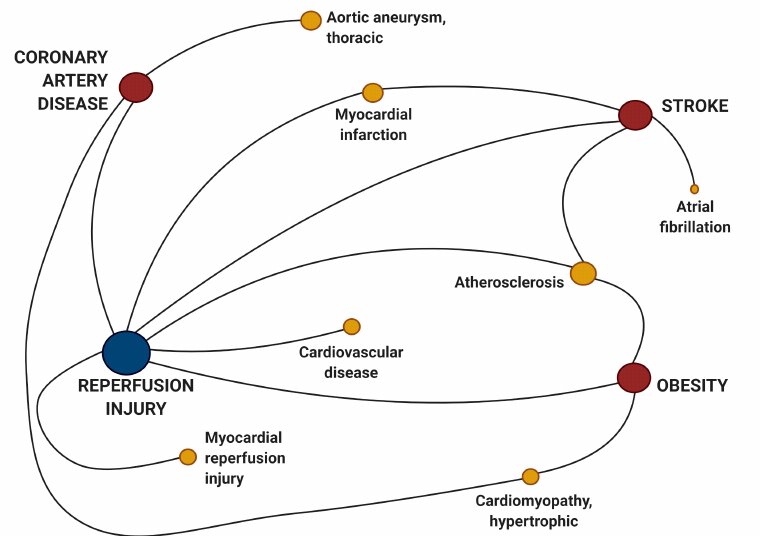
Figure 2. Visualization of hsa-miR associated with ischemia/reperfusion injury. Ischemia/reperfusion injury network was created via the integration of hsa-miR–disease association data with the categories “genetics”, “epigenetics”, “circulating”, and “target” inputted into the Human microRNA Disease Database. This figure was created using Biorender.com.